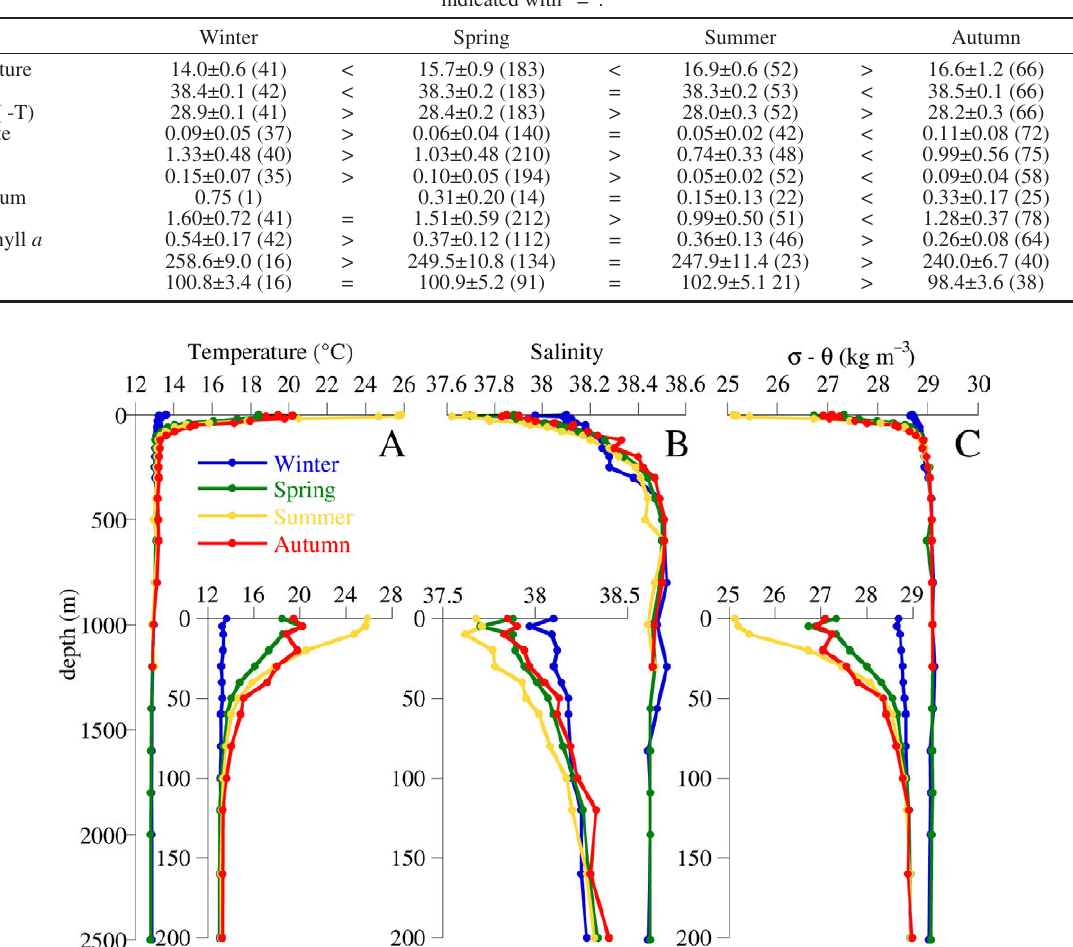
Fig. 2. – Seasonal depth concentration profiles of temperature (A), salinity (B), and density anomaly (C) in open sea stations (bottom depth>200 m) of the Catalan Sea. The first 200 m are enlarged in the small